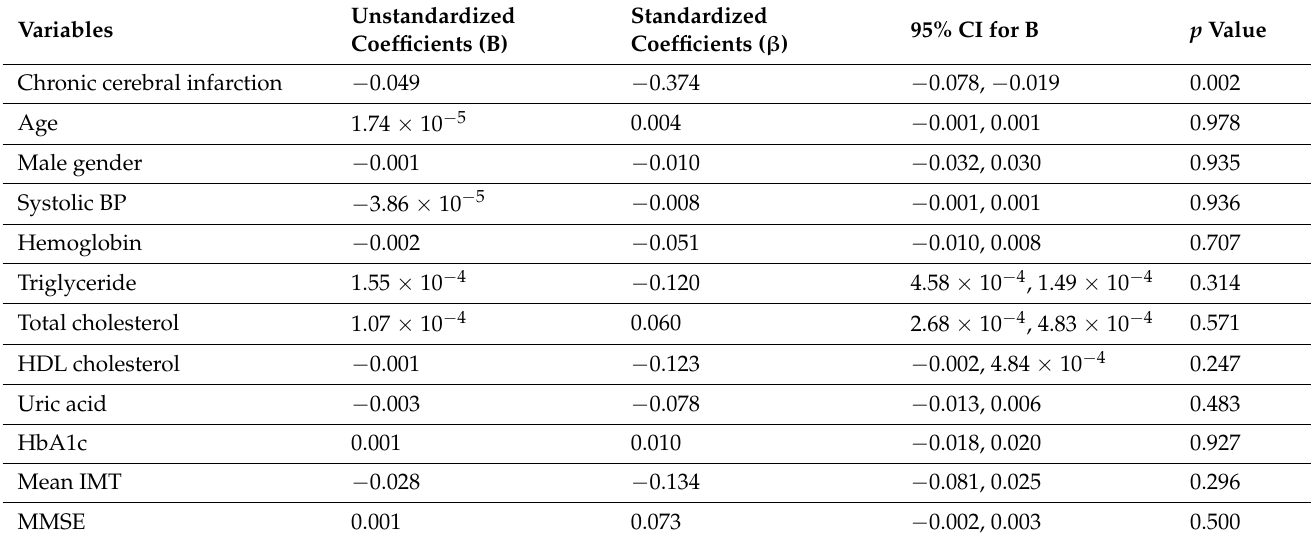
Table 4. Partial regression coefficients of variables that affected fluctuations in cerebral